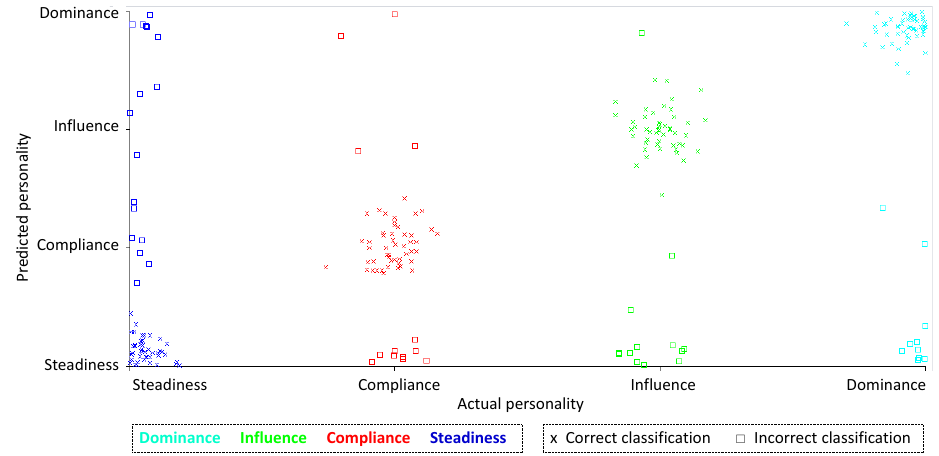
Figure 4. Actual personality versus predicted personality comparation.